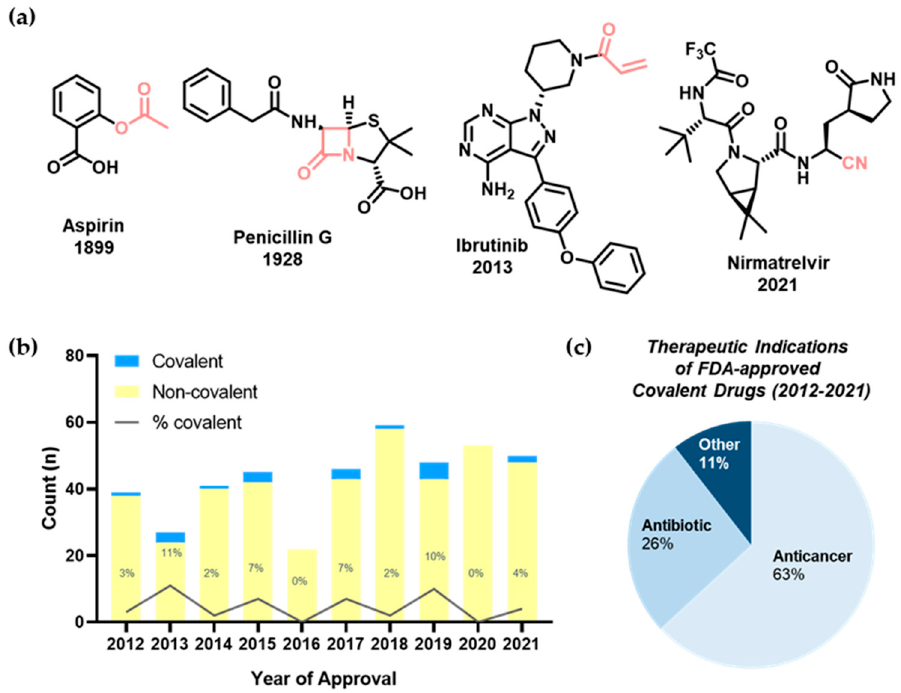
Figure 1. ( a ) Chemical structures of representative covalent inhibitors in early and recent years. ( b ) Overview of small-molecule covalent inhibitors in past decades (FDA approvals 2012–2021). The chart shows novel small-molecule covalent inhibitors among FDA approvals including new molec- ular entities (NMEs) and biologics license applications (BLAs). ( c ) Therapeutic indications of cova- lent inhibitors (total n = 19); anticancer (63%, n = 12), antibiotic (26%, n = 5), other (11%, n = 2).